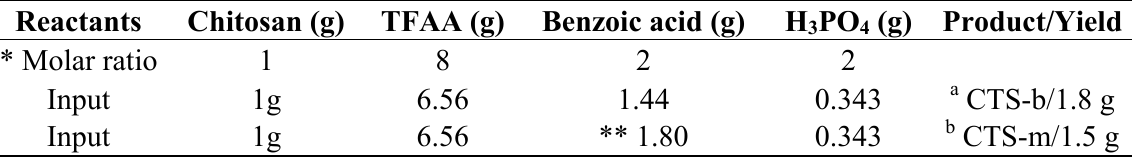
Table 1. The yields of the chitosan benzoylation using TFFA, BAs, and